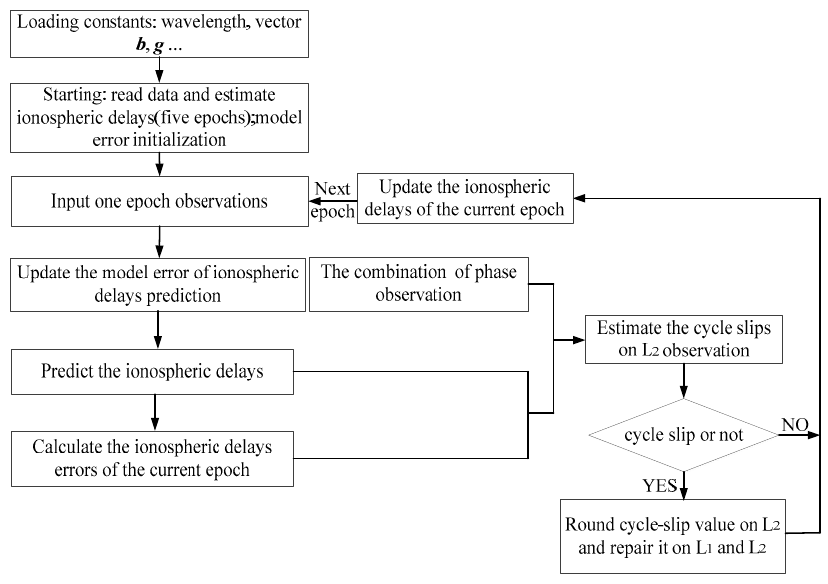
Figure 1. Flowchart of the improved cycle-slip detection and repair algorithm. Table 2. The fractional part of estimated L 2 observations on G01 (cycle).